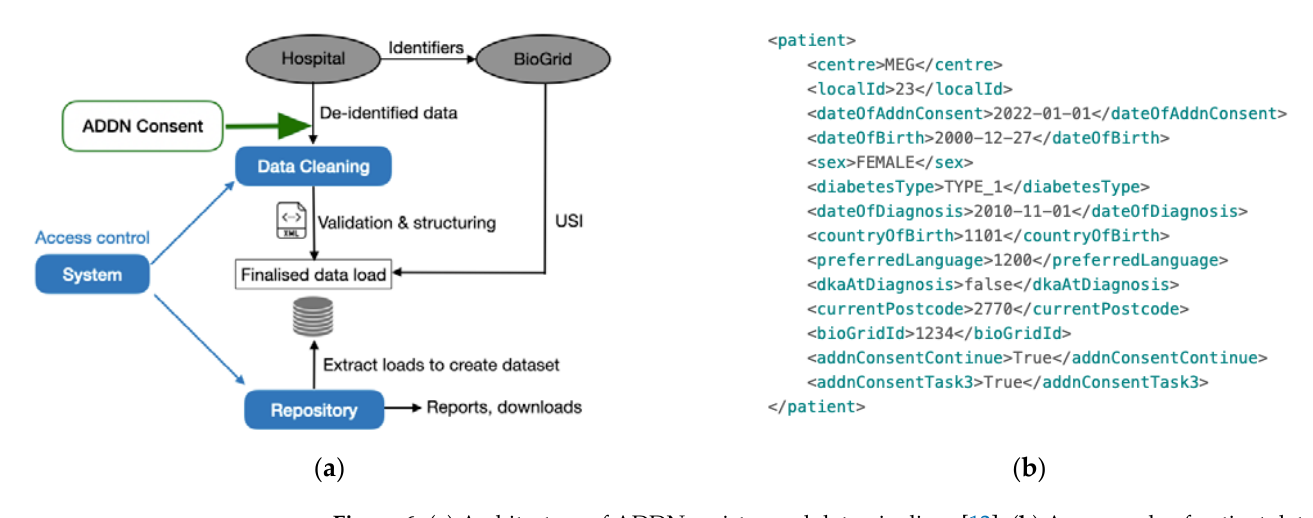
Figure 6. ( a ) Architecture of ADDN registry and data pipelines [12]. ( b ) An example of patient data with a merged opt-in consent result